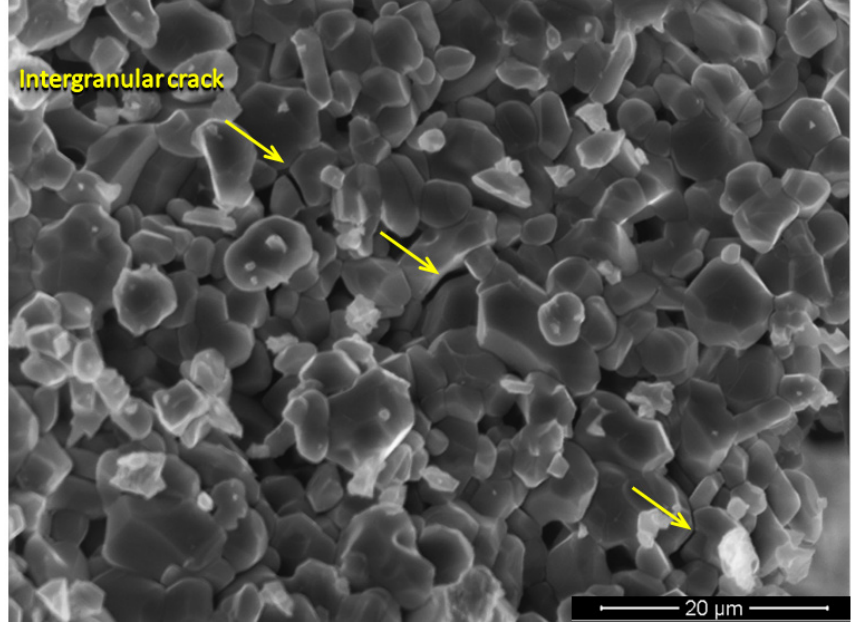
Figure 8. SEM image of ceramic intergranular fragmentation after ballistic test.